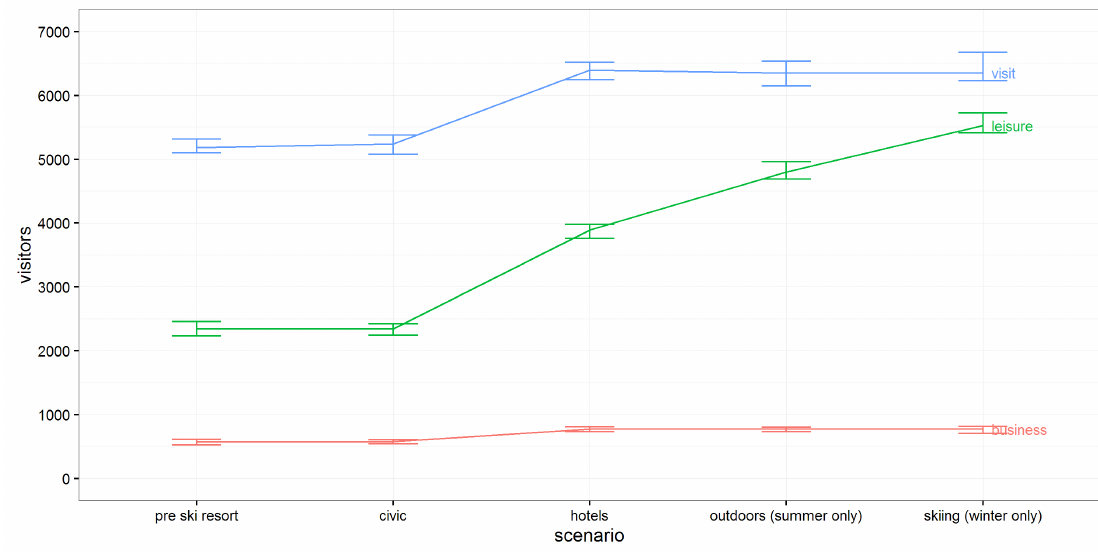
Figure 5. Scenario analysis: Impact of a new ski resort on Dufferin (Toronto CMA).